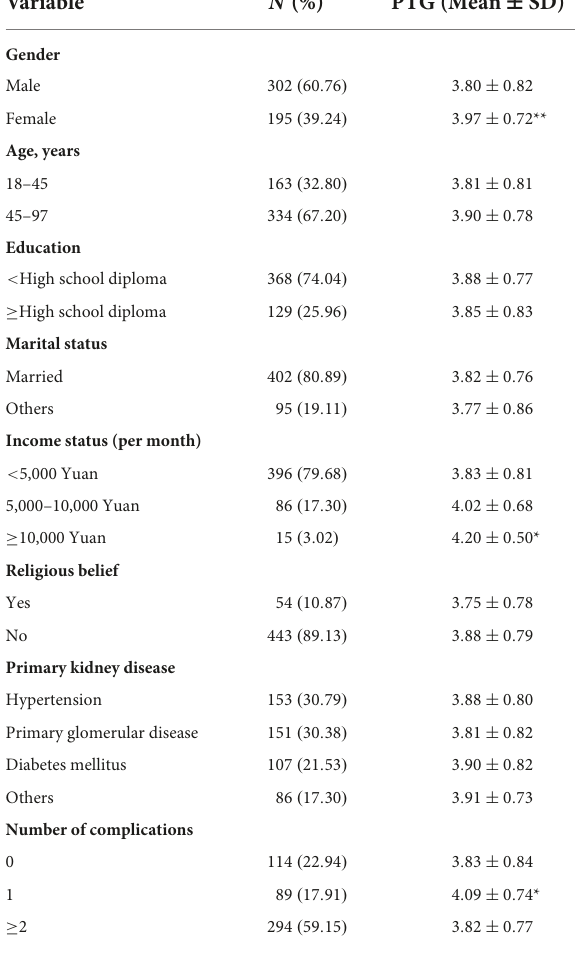
TABLE 1 Demographic characteristics and disease-related information and distributions of post-traumatic growth (PTG) among hemodialysis patients ( N = 497).